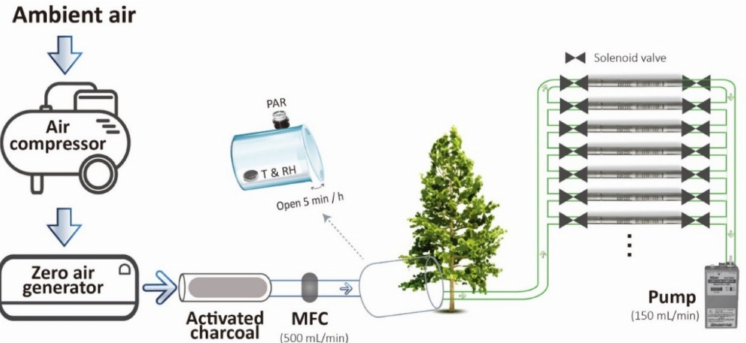
Figure 2. Scheme of sampling devices for collecting the BVOCs emitted from leaves. MFC, mass flow controller; PAR, photosynthetically active radiation; T, temperature; RH, relative humidity.